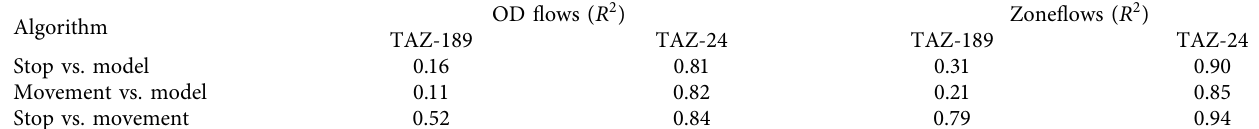
Table 6: Correlation between the travel demand inferred from cellular network data by different algorithms and the municipality’s demand model for both TAZ-189 and TAZ-24 zoning regarding the flow in each OD pair and the zoneflow (total inflow +outflow) for each zone. Zone internal flows and OD pairs with origin/destination outside of the municipality are not included.